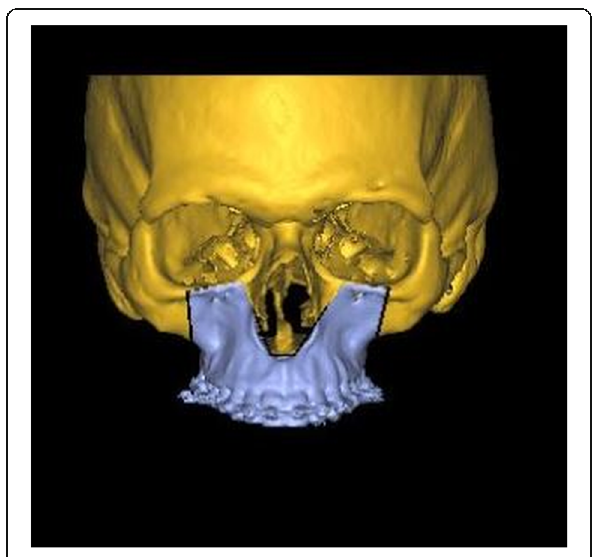
Fig. 1 IQLFIIO segment planned in ProPlan CMF ®